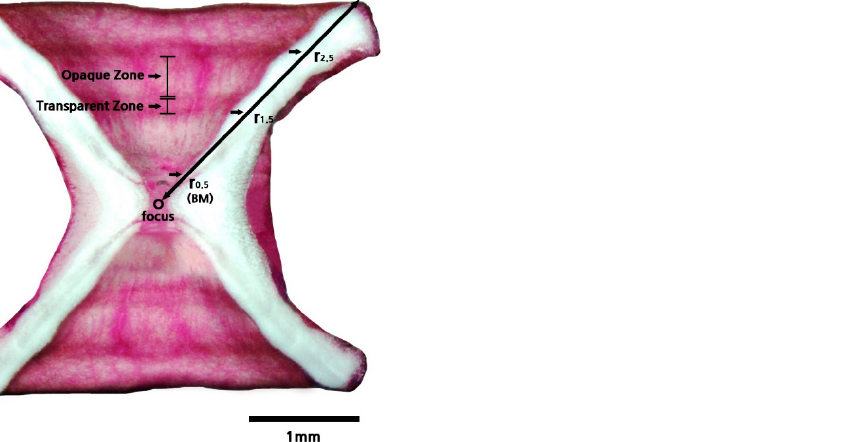
Figure 3. Measurement of the vertebral centrum radius in Okamejei kenojei , where r n represents the distance to the growth ring at = n and r 0 represents the fi rst growth ring.